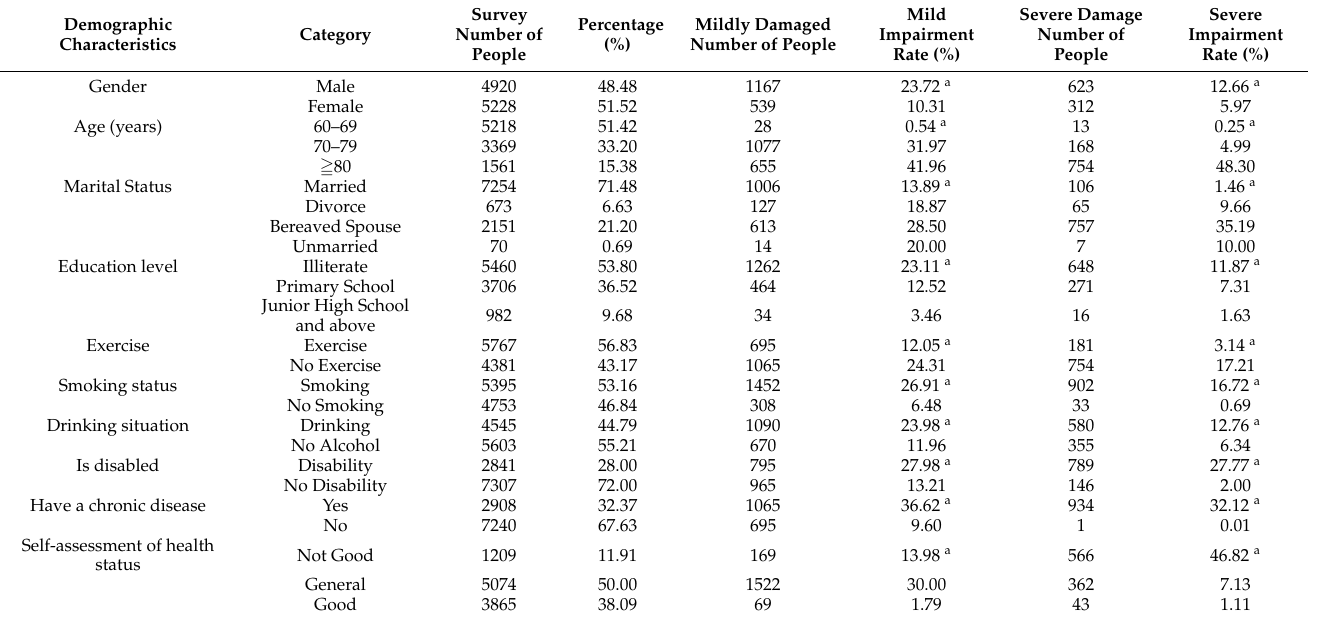
Table 1. Comparison of activities of daily living ability among older adults with different